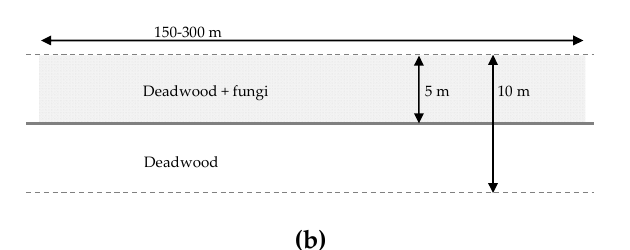
Figure 2. ( a ) Circular plots of 500 m 2 (the light grey), trees on the cardinal points (small dark grey circles), transects of 15 m oriented in 30°, 150°, and 270° (black line), concentric circular sub-plots of 5 m 2 (regeneration type 1), 10 m 2 (regeneration type 2), and 20 m 2 (regeneration type 3). Methodology based on Commarmot et al. [25] survey. ( b ) Transects of 150–300 m length and 5 m width to sample the saproxylic community and 10 m width to sample deadwood.